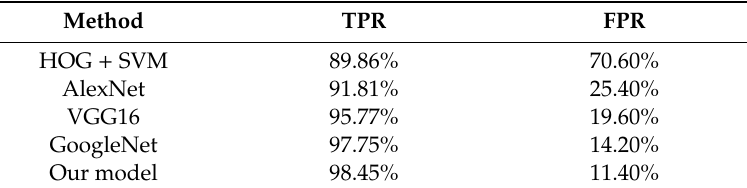
Table 3. TPR, FPR of our method and competing methods.